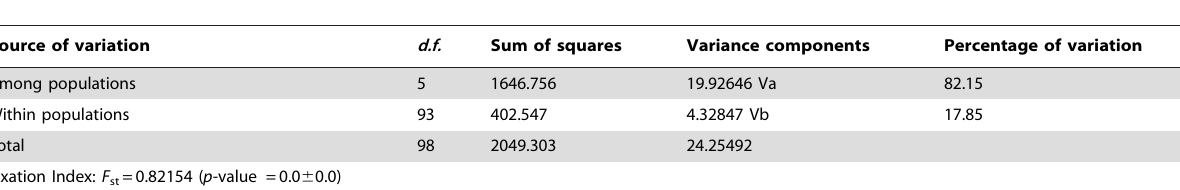
Table 3. Results of analysis of molecular variance (AMOVA) of S. ningshanensis .